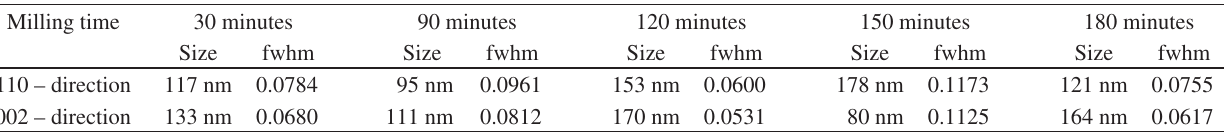
Table 1. Average grain size of the samples with low milling time. Average error is 1 nm.